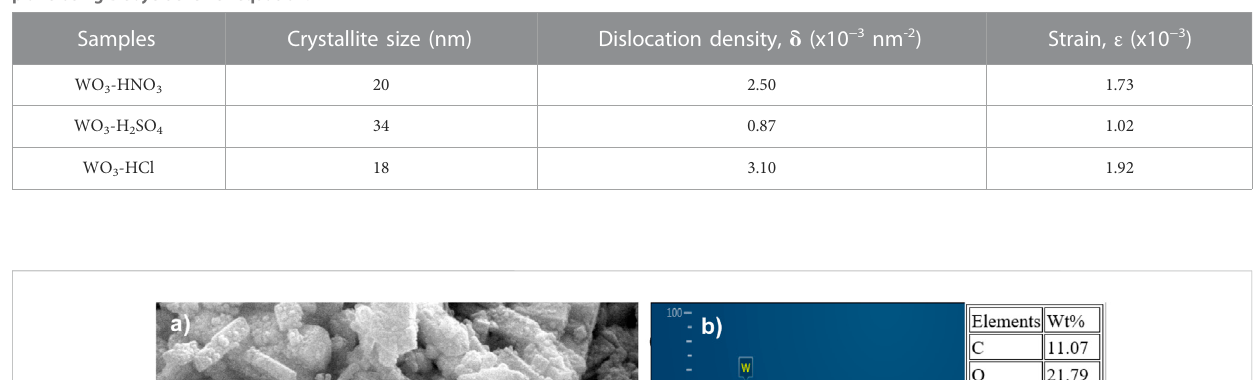
hierarchical nanostructures of WO 3 -HCl, however, small nanoparticles can be observed on the surface morphology of this sample, which are more noticeable than on the WO 3 -HNO 3 . It is clear that, the type of acids precipitants (HNO 3 , H 2 SO 4 , and HCl) in fl uenced the morphological structure of the samples, which also affects their gas sensing performance (Karaduman Er et al., 2022).